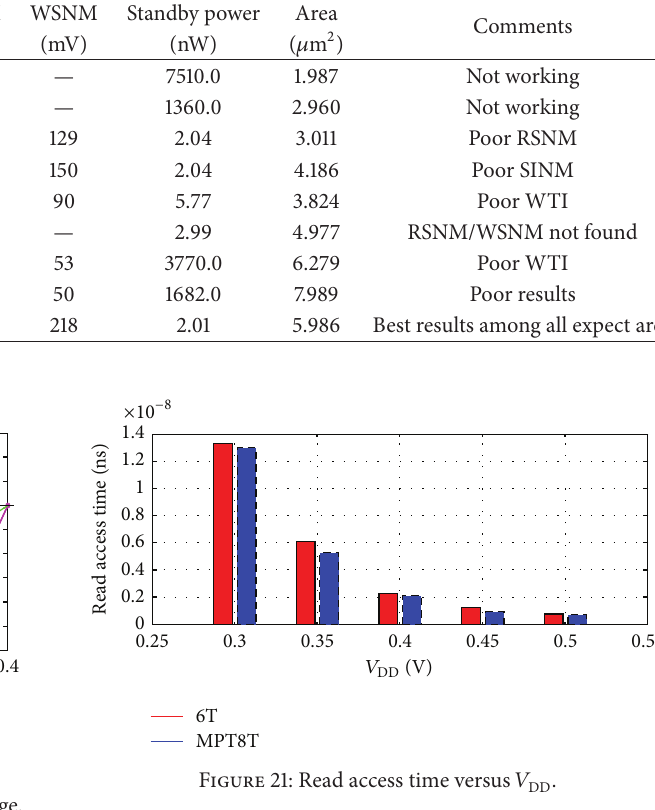
Figure 19: SINM, SVNM, and WTI versus internal node voltage.